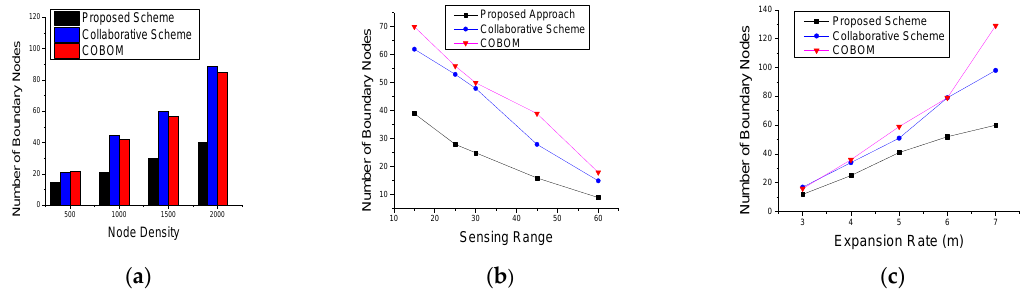
Figure 8. Number of boundary nodes with different ( a ) node densities; ( b ) sensing ranges; and ( c ) expansion rates.